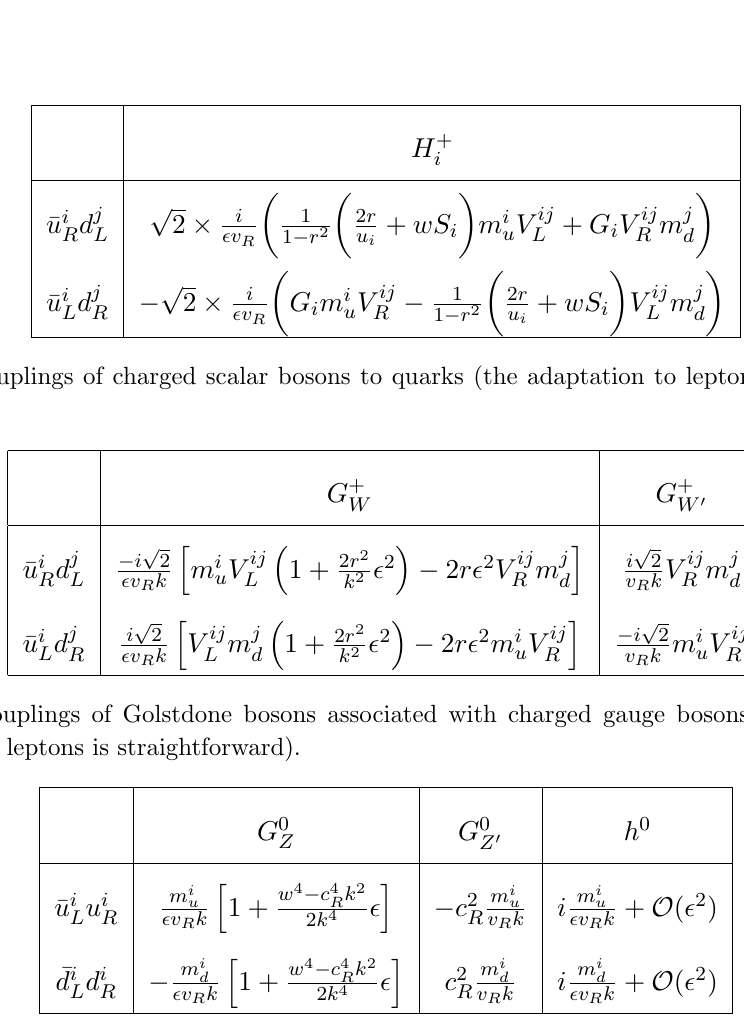
Table 10 . Couplings of Golstdone bosons associated with neutral gauge bosons to quarks (the adaptation to leptons is straightforward). The O ( (cid:15) 2 ) corrections to h 0 have a rather complicated expression, involving various contributions from the scalar potential.